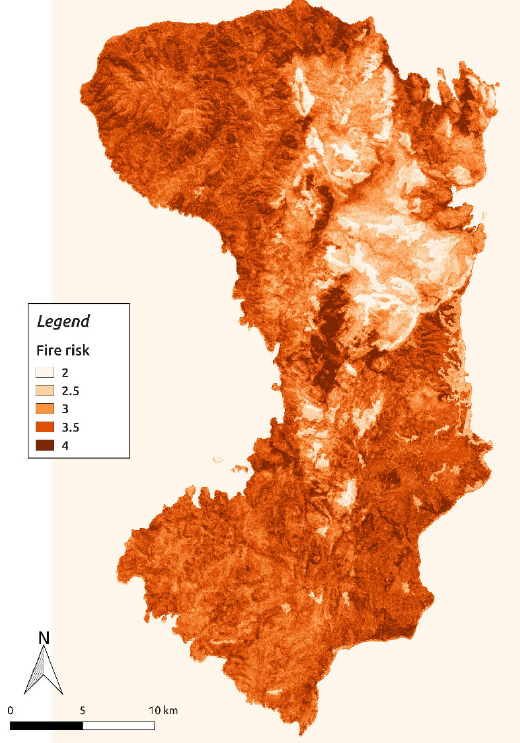
Figure 7. The fire risk map as a final product of the proposed approach. All the input layers were resampled to a 30 m × 30 m grid for the production of the map, equivalent to the 30 m spatial resolution of the Landsat satellite. Table 4. Pair-wise comparison of the fire risk factors for the extraction of the relevant weights.